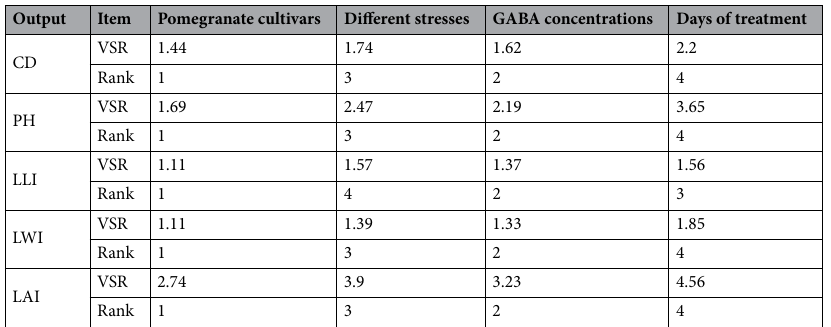
Table 2. The sensitivity analysis to rank the importance of each input for (PH) plant height, (CD) crown diameter, (LLI) leaf length index, (LWI) leaf width index and (LAI) leaf area index of pomegranate. VSE variable sensitivity error, VSR variable sensitivity ratio.